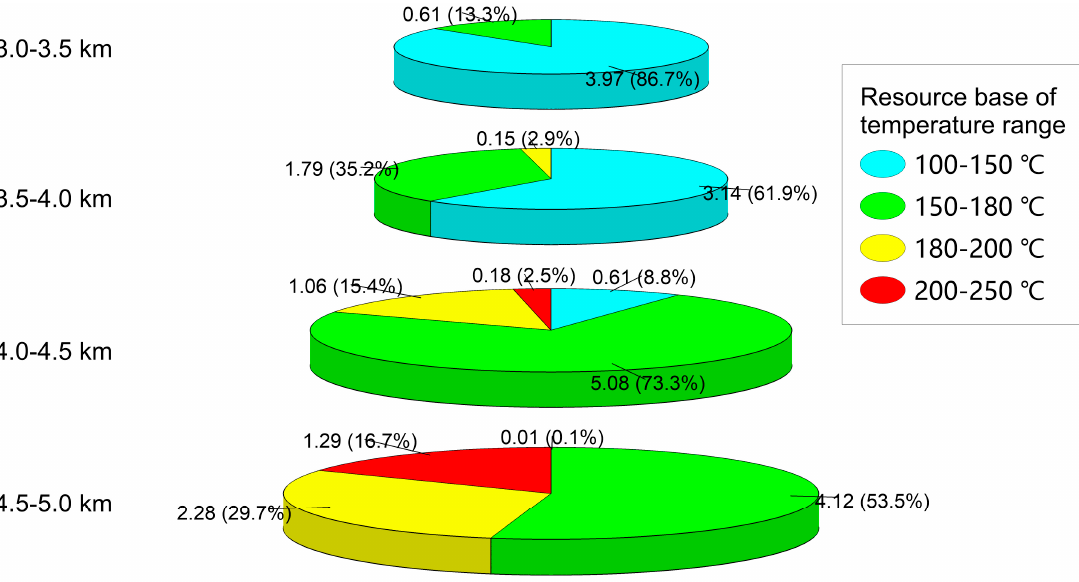
Figure 5. Heat content in place with various temperature ranges in the 0.5 km thick depth intervals from 3 to 5 km. The area of the pie represents the amount of the heat content. The number in front is the heat content in 10 21 J, the number in the bracket is the percentage of the different temperature ranges in specific depth interval.